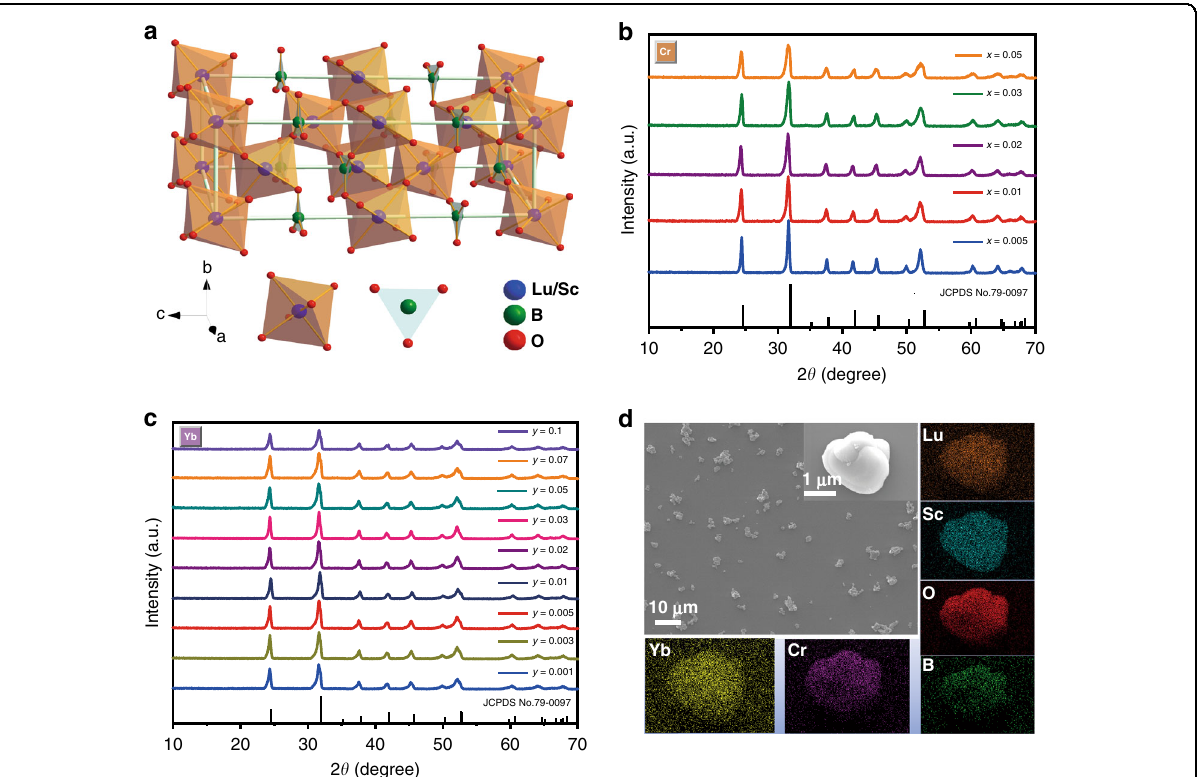
Fig. 1 Crystal structure and morphology. a Crystal structure of Lu 0.2 Sc 0.8 BO 3 compound and the coordination diagrams of trivalent cations. b , c XRD patterns of Lu 0.2 Sc 0.8 BO 3 : x Cr 3 + ( x = 0.005 – 0.05) and Lu 0.2 Sc 0.8 BO 3 :2%Cr 3 + , y Yb 3 + ( y = 0.001 – 0.1). d SEM and corresponding elemental mapping of Lu 0.2 Sc 0.8 BO 3 :2%Cr 3 + , 5%Yb 3 +